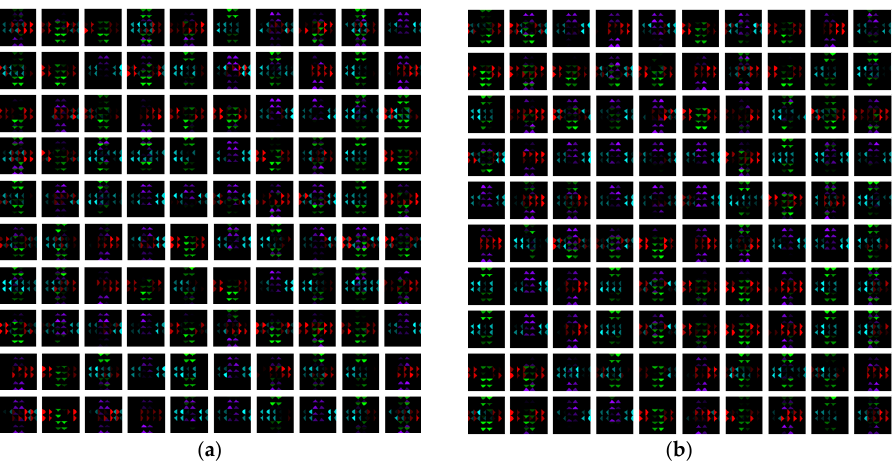
Figure 4. Generated simulation datasets. ( a ) Training set. ( b ) Test set.